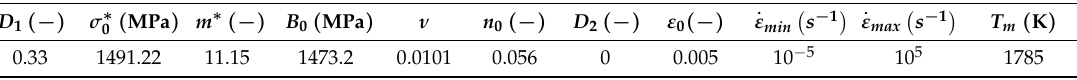
Table 5. Parameters of the Rusinek–Klepaczko model for the investigated high strength